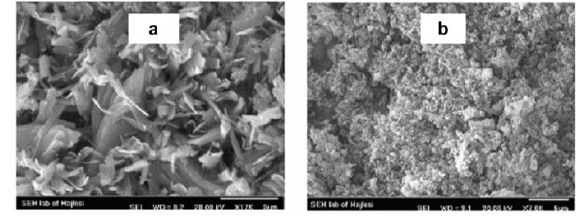
Figure 3. Scanning electron microscope image of (a) granules and (b) the morphology of the microorganisms on the surface of